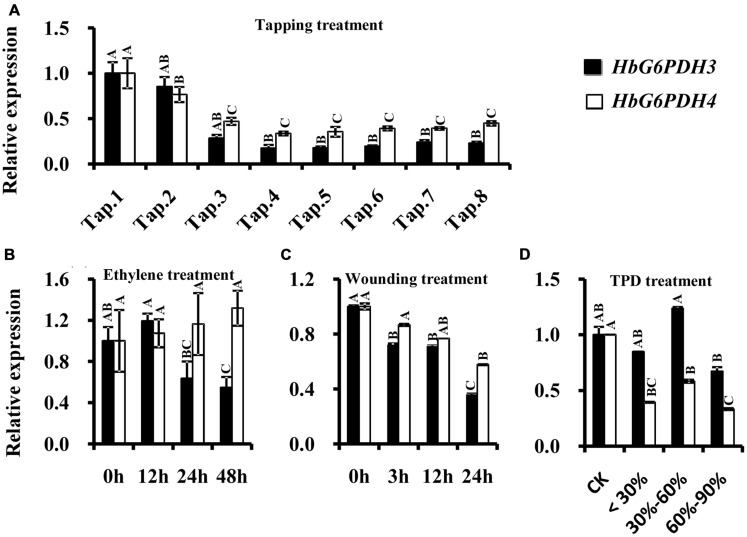
Responses of HbG6PDH3 and HbG6PDH4 to tapping (A), ethylene (B), wounding (C), and different severities of tapping panel dryness (TPD), (D). Different capital letters indicate a significant difference at 0.01 level for the same gene.